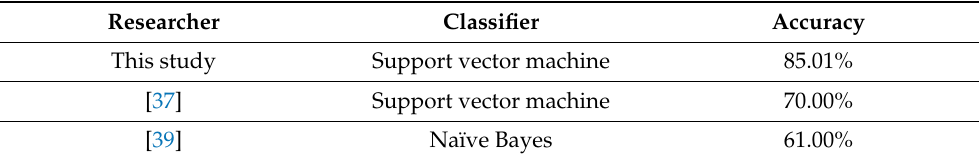
Table 9. Inter-subject classification